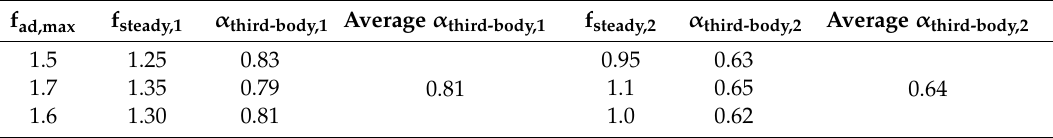
Figure 10. Typical development of the coefficient of friction. Table 3. Coefficient of friction and the influence of the third bodies.